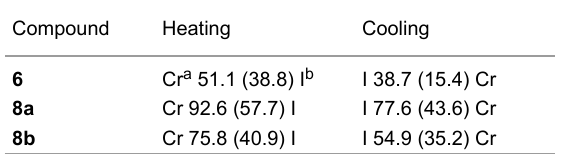
Table 1: Transition temperatures (°C, peak temperature) and enthal- pies (kJ/mol in parentheses) of the banana-discotic dimers both on heating and cooling at the scan rate of 5